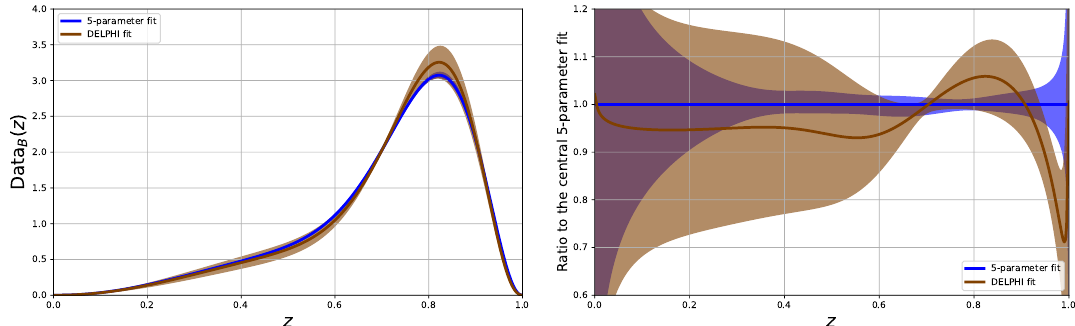
Figure 4 . Comparison of the 5 -parameter fit (blue) with the fit from ref. [80] (brown). Absolute distributions (left) and their ratio (right). The blue error band corresponds to the r.m.s. of the 100 data fits while the brown error band corresponds to the propagated errors on the fitted parameters taken from table 12 of ref.